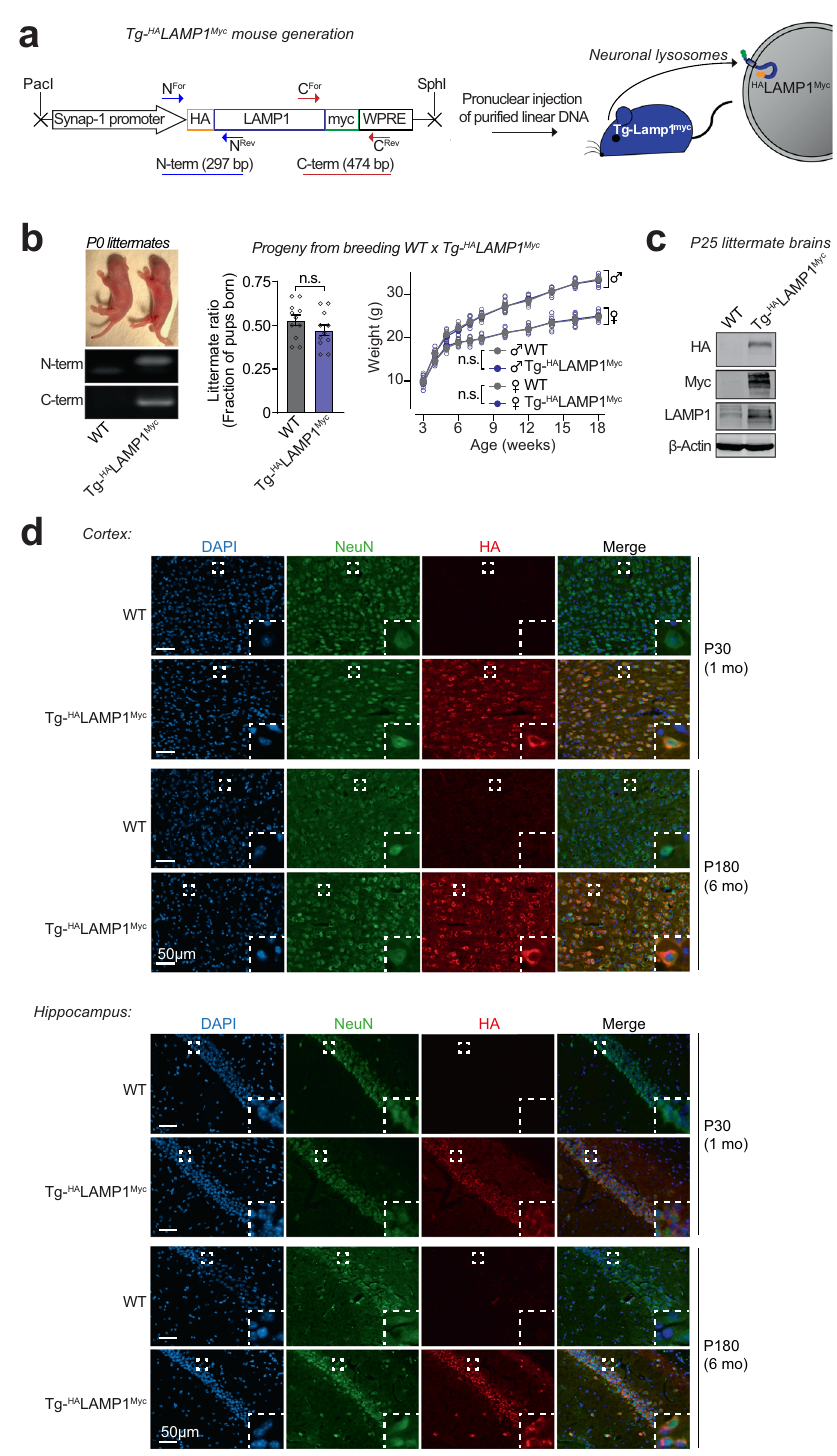
Fig. 2 | Development of a transgenic mouse model (NeuLyso-Tag mouse) to isolate neuronal lysosomes from brains. a A lentiviral vector expressing HA LAMP1 Myc via the neuron-speci fi c synapsin-1 promoter was used to generate Tg- HA LAMP1 Myc (or “ NeuLyso-Tag ” ) mice via pronuclear injection of linearized DNA comprising the synapsin-1 promoter and the HA LAMP1 Myc cDNA. b Tg- HA LAMP1 Myc mice were PCR-genotyped using primer-pairs at the N- and the C-terminal ends of the HA LAMP1 Myc cDNA. Single insertion-site for the transgene was suggested by equal numbers of WT and Tg- HA LAMP1 Myc pups born per litter ( n =11 litters).There was also no effect of the transgene on birth-ratio and growth (indicated by weight gain; n =5 per group) of the Tg- HA LAMP1 Myc mice compared to WT mice. c Immunoblots show that HA LAMP1 Myc protein is detectable in mouse brains by